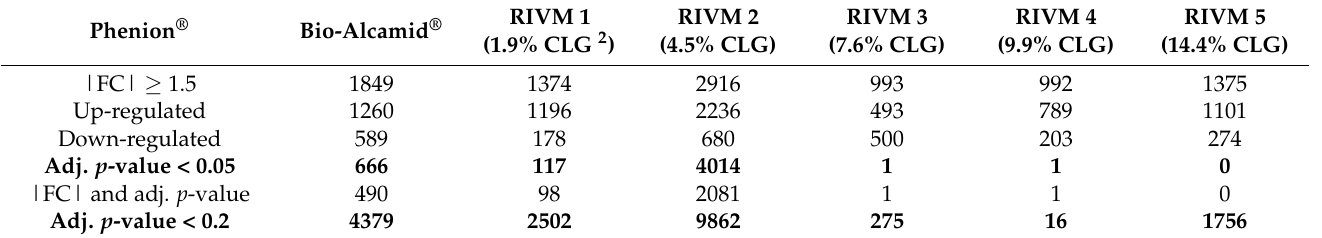
Table 1. DEGs for the Phenion ® Full-Thickness Skin model exposed to Bio-Alcamid ® and RIVM 1 preparations. The number of genes significantly different compared to non-treated control cells is indicated in bold.